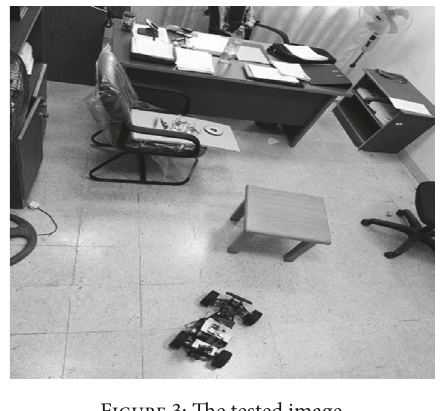
Figure 3: The tested image.